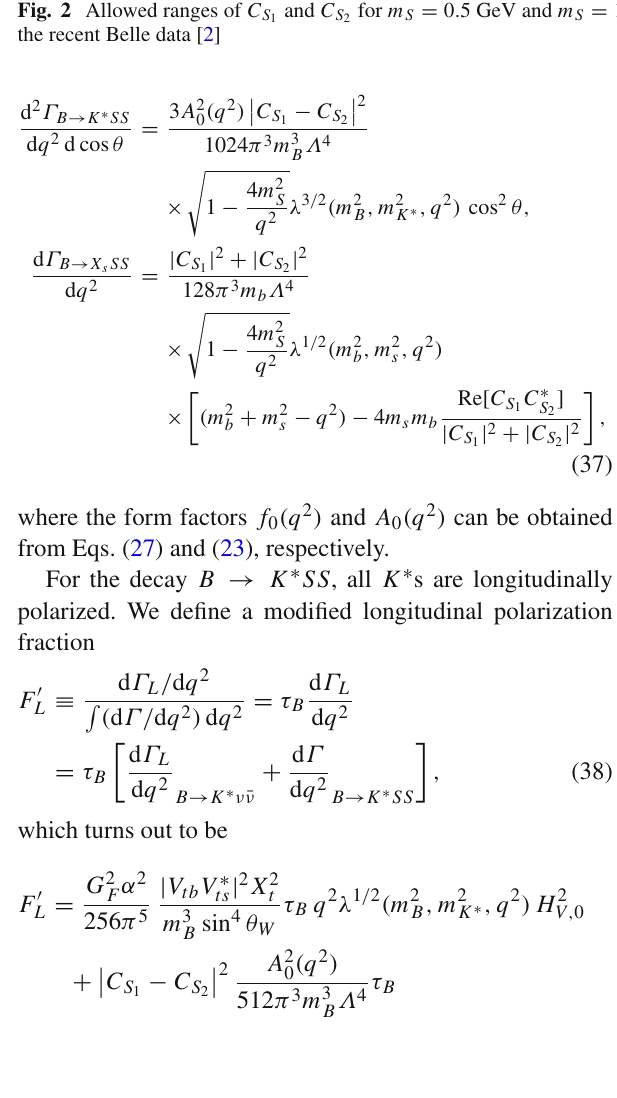
and C S for m S = 0 . 5 GeV and m S = 1 . 8 GeV, taking Λ = 1 TeV. Also shown is the truncated region allowed by 1 2